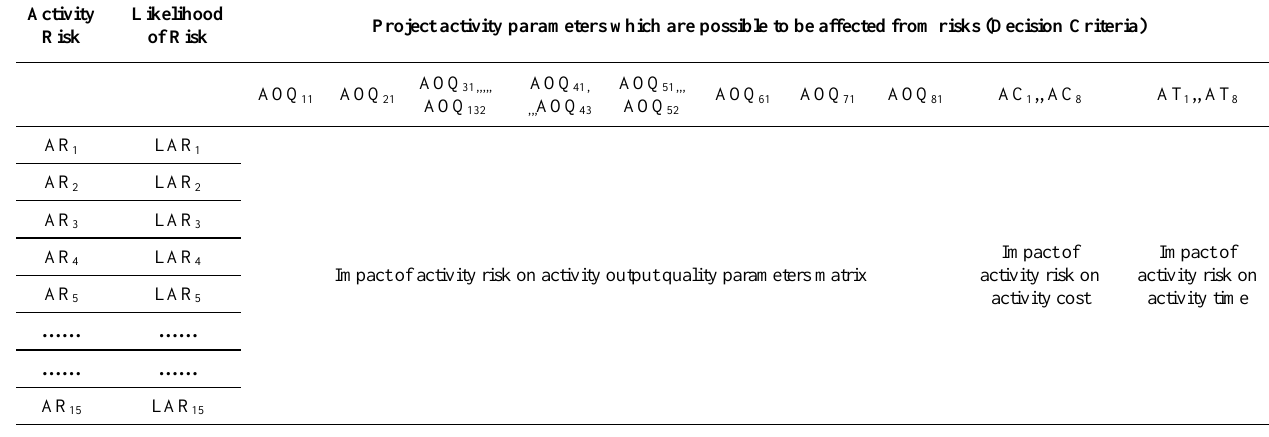
Table 10. Dimension of initial TOPSIS table of